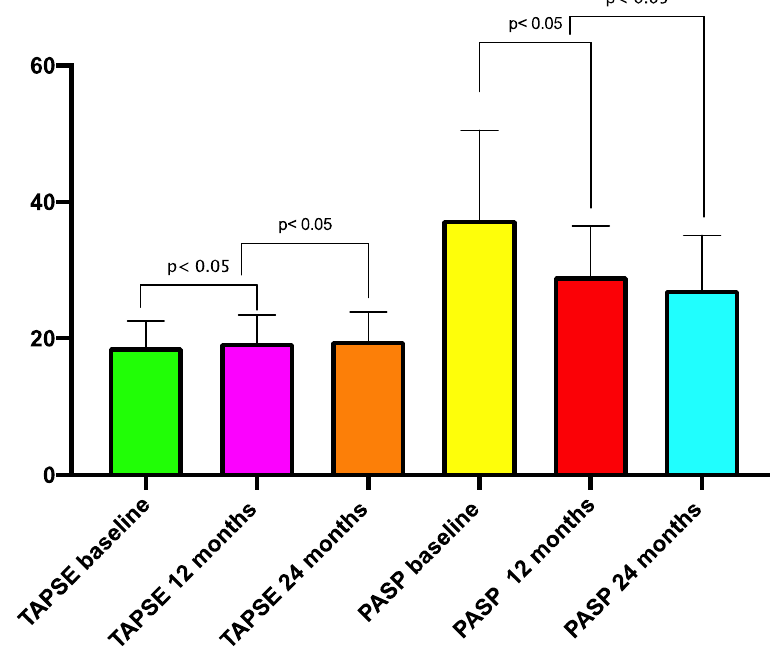
Figure 1. Changes in the TAPSE and PAPS during follow-up. TAPSE—tricuspid annular systolic pressure; PAPS—pulmonary artery systolic pressure.